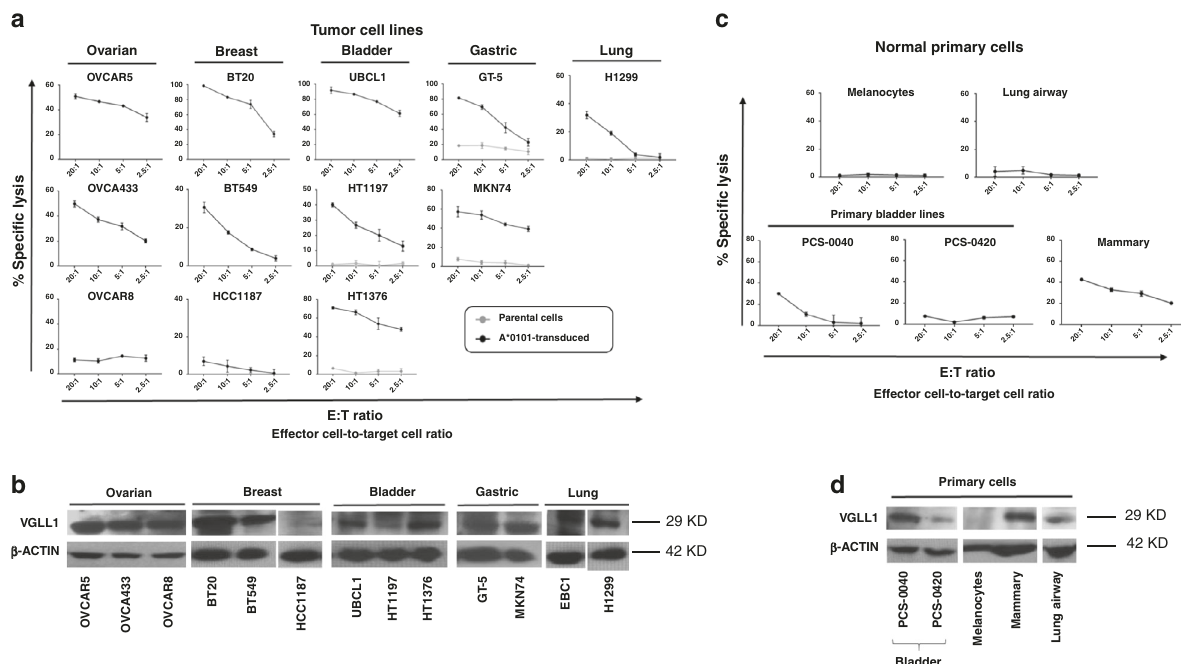
Fig. 6 VGLL1-speci fi c T cells recognize and kill multiple tumor types, but have reduced recognition of primary tissue cell lines. a VGLL1-speci fi c CD8 + T cells were co-cultured with 12 different HLA-A*0101-expressing tumor cell lines derived from ovarian, lung, breast, bladder, or gastric cancer in a standard 51 Cr release assay to measure cytotoxic activity at different effector-to-target (E:T) cell ratios. Five HLA-A*0101-negative cell lines (H1299, HT1197, HT1376, GT-5, and MKN74) were lentivirally transduced to stably express HLA-A*0101; speci fi c killing of the parental cell lines (gray lines) are shown in comparison to HLA-A*0101-transduced counterparts (black lines). Data are presented as mean values from three independent experiments + / − SD. b Western blot analysis showing VGLL1 protein expression in tumor cell lines derived from ovarian, lung, breast, bladder, or gastric cancers was repeated three times with similar results. c VGLL1-speci fi c CTLs were co-cultured with HLA-A*0101-expressing primary tissue cells derived from bladder, breast, lung airway, or skin melanocytes in a standard 51 Cr release assay to measure cytotoxic activity. Cytolysis assay results show the means and standard deviations of six replicate samples, and data is representative of three independent experiments. d VGLL1 protein expression in primary cell lines as assessed by Western blot analysis was repeated three times with similar